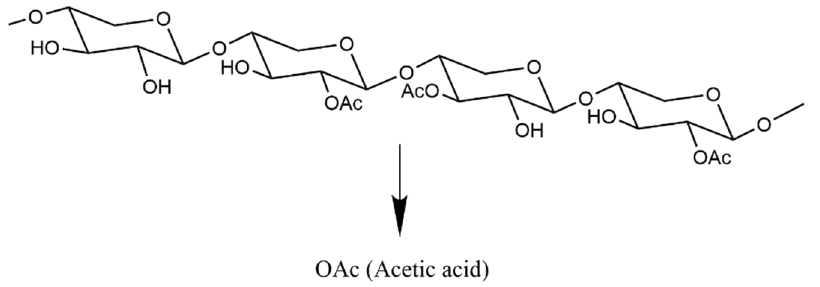
Figure 9. Acetylated xylan. The release of acetic acid is achieved by the action of acetyl xylan esterase on acetylated xylan.